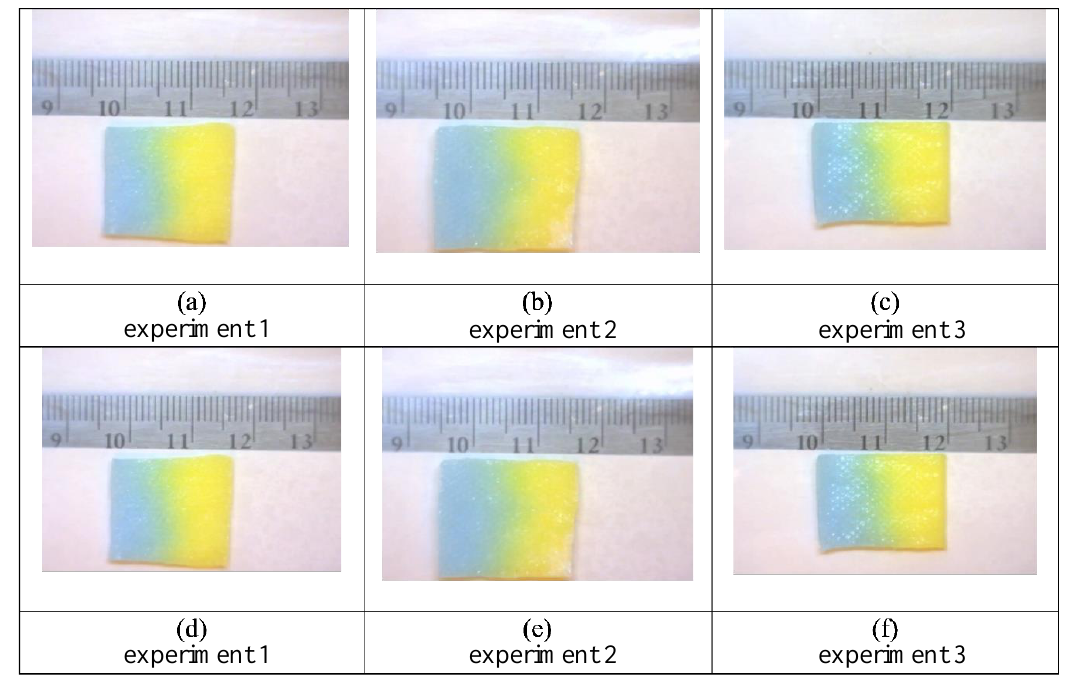
Figure 9. These are still frames from triplicate experiments (1–3) also shown in Figure 7. The panels above show unprocessed images for an initial application of 50% glycerol (yellow) followed by 100% water (blue). Images ( a – c ) are at 5 min and images ( d – f ) are at fifteen minutes. While there is some visual evidence of dye diffusion at the interface between the two colored liquids, the color variations within the gauze pads are not visible, as in Figure 7, without imaging processing to accentuate the subtle changes of color due to mixing.